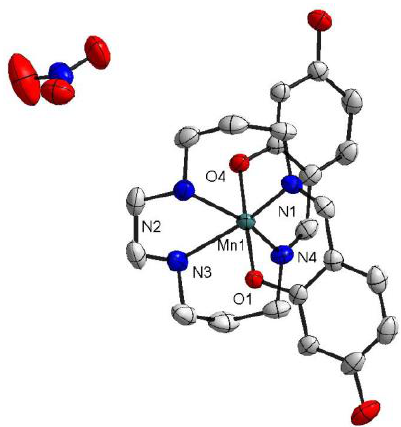
Figure 1. The structure of [Mn(4-OH-sal-N-1,5,8,12)]NO 3 at T = 100 K. Ellipsoids are drawn at the 50% probability level. Hydrogen atoms were omitted for clarity.